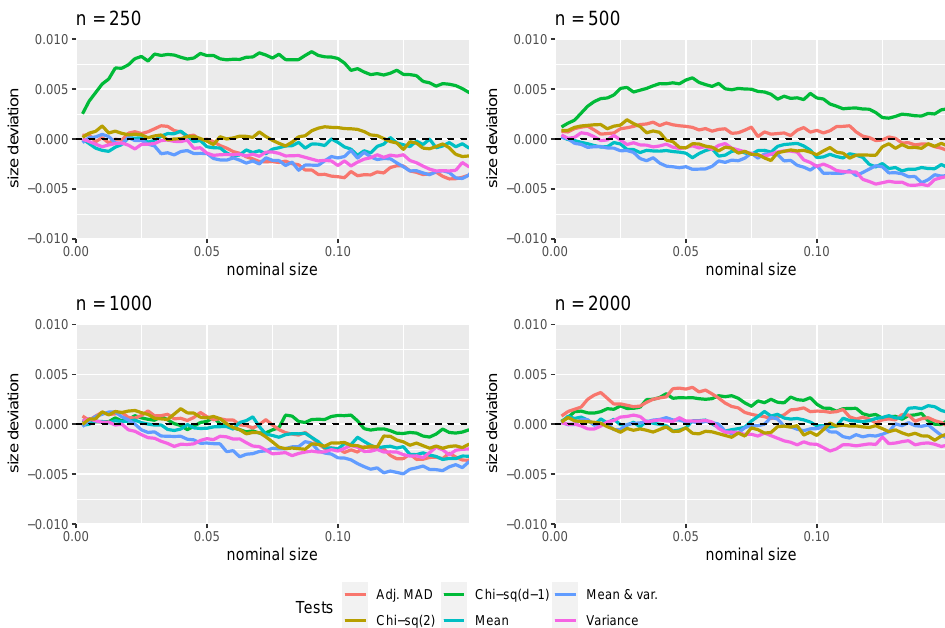
Figure 6. First two digits tests: deviation of the actual size from the nominal size. Tests are as follows: “Adj. MAD”, adjusted MAD (10); “Chi-sq(2)”, χ 2 ( 2 ) test on mean and variance (4); “Chi-sq(d-1)”, χ 2 ( 89 ) test (9); “Mean”, normal test on the mean (1); “Mean & var.”, normal test on mean and variance (3); “Variance”, normal test on variance (2). The number of observations is indicated on top of each